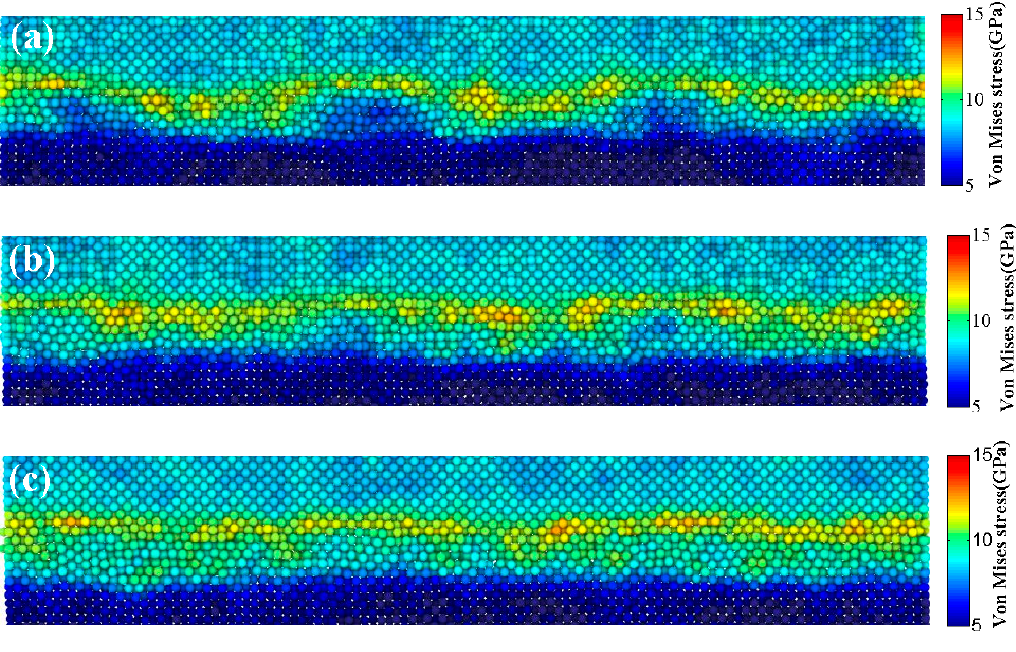
Figure 5. Stress distribution of the weld zone at: ( a ) 1 ns, ( b ) 3 ns, and ( c ) 5 ns.